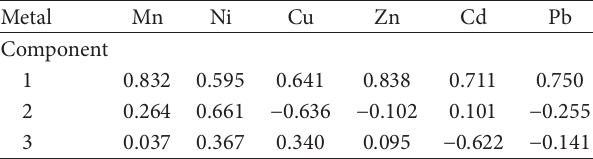
Table 4: Content loading matrix of the